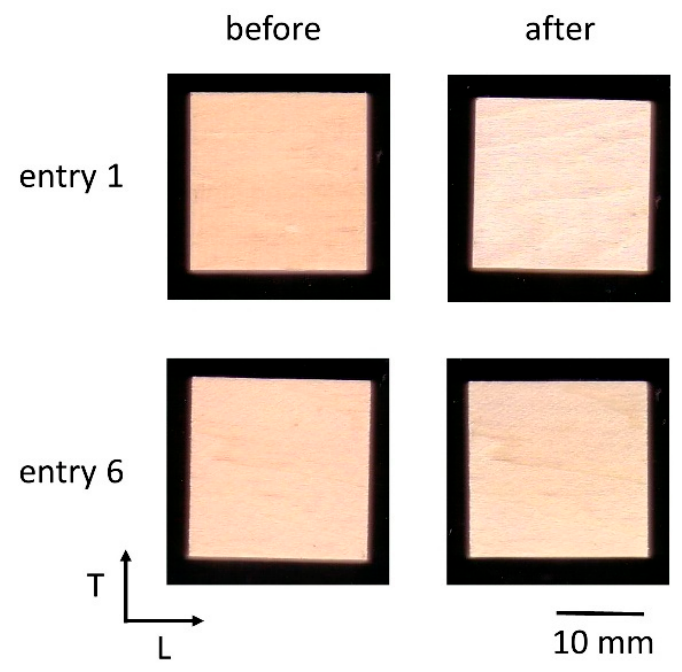
Figure 2. Photographs of block-shaped woods before and after benzylation with conventional (entry 1) or novel (entry 6) method.